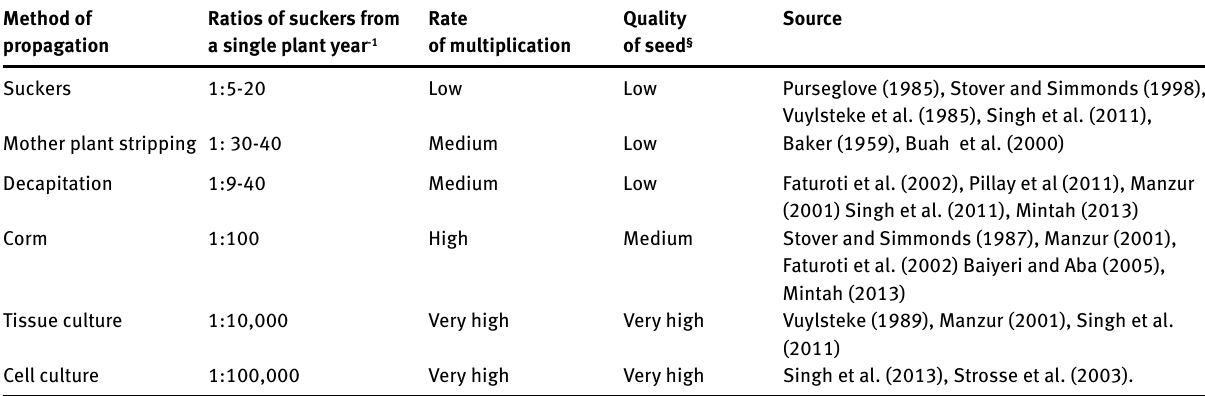
Table 2: Some attributes of the different banana propagation methods and their respective advantages of quantity and quality of plantlets they generate in a single year Method of